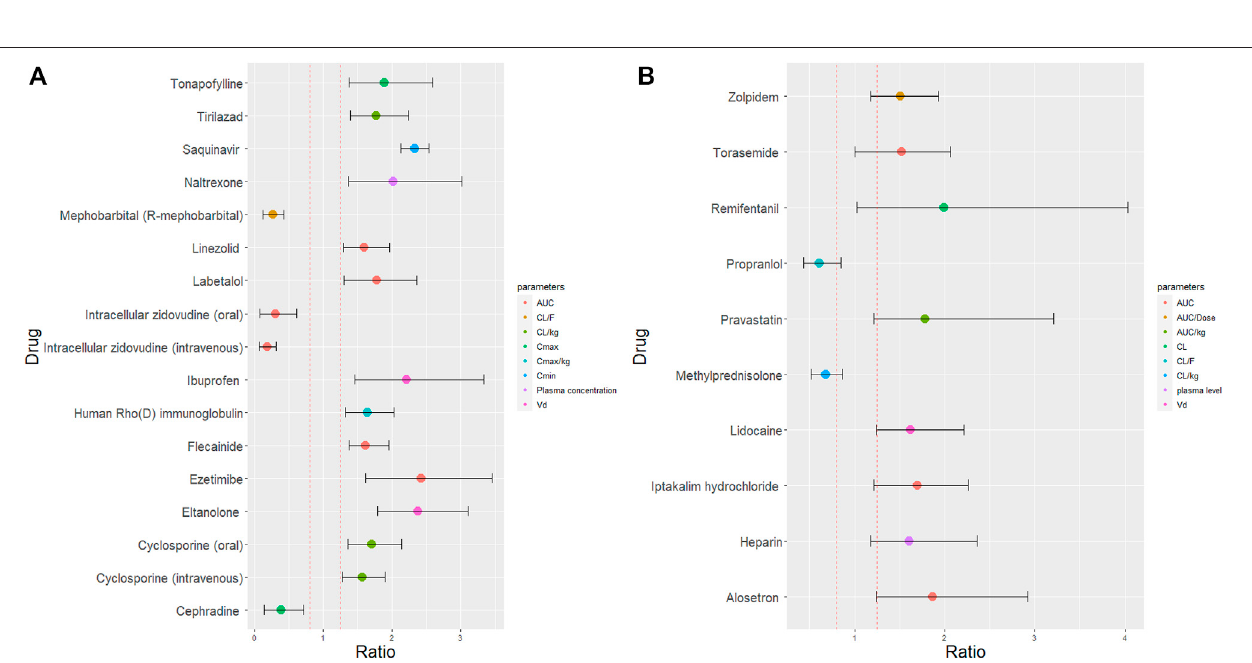
FIGURE2| FemaletomaleratioofobservedPKparametersofanticancerdrugs.Theratiorangesfrom0.40(smallerPKvalueinwomen)to2.29(largerPKvaluein women) with the 90% con fi dence interval indicated by error bars. Red dashed lines indicate bioequivalence window from 0.8 to 1.25. PK abbreviations: clearance (CL), maximum plasma concentration (Cmax), volume of distribution to peripheral compartments (V2), volume of distribution of central compartment (VC).